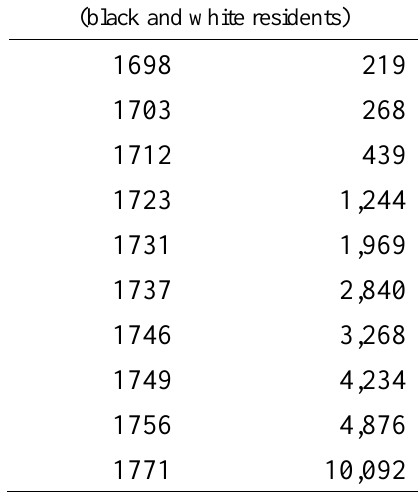
Table 2: Orange County Population (black and white